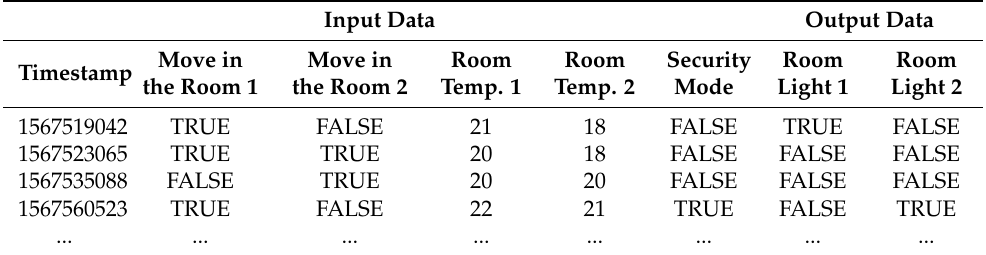
Table 3. A fragment of the training sample data to ensure an optimal lighting.